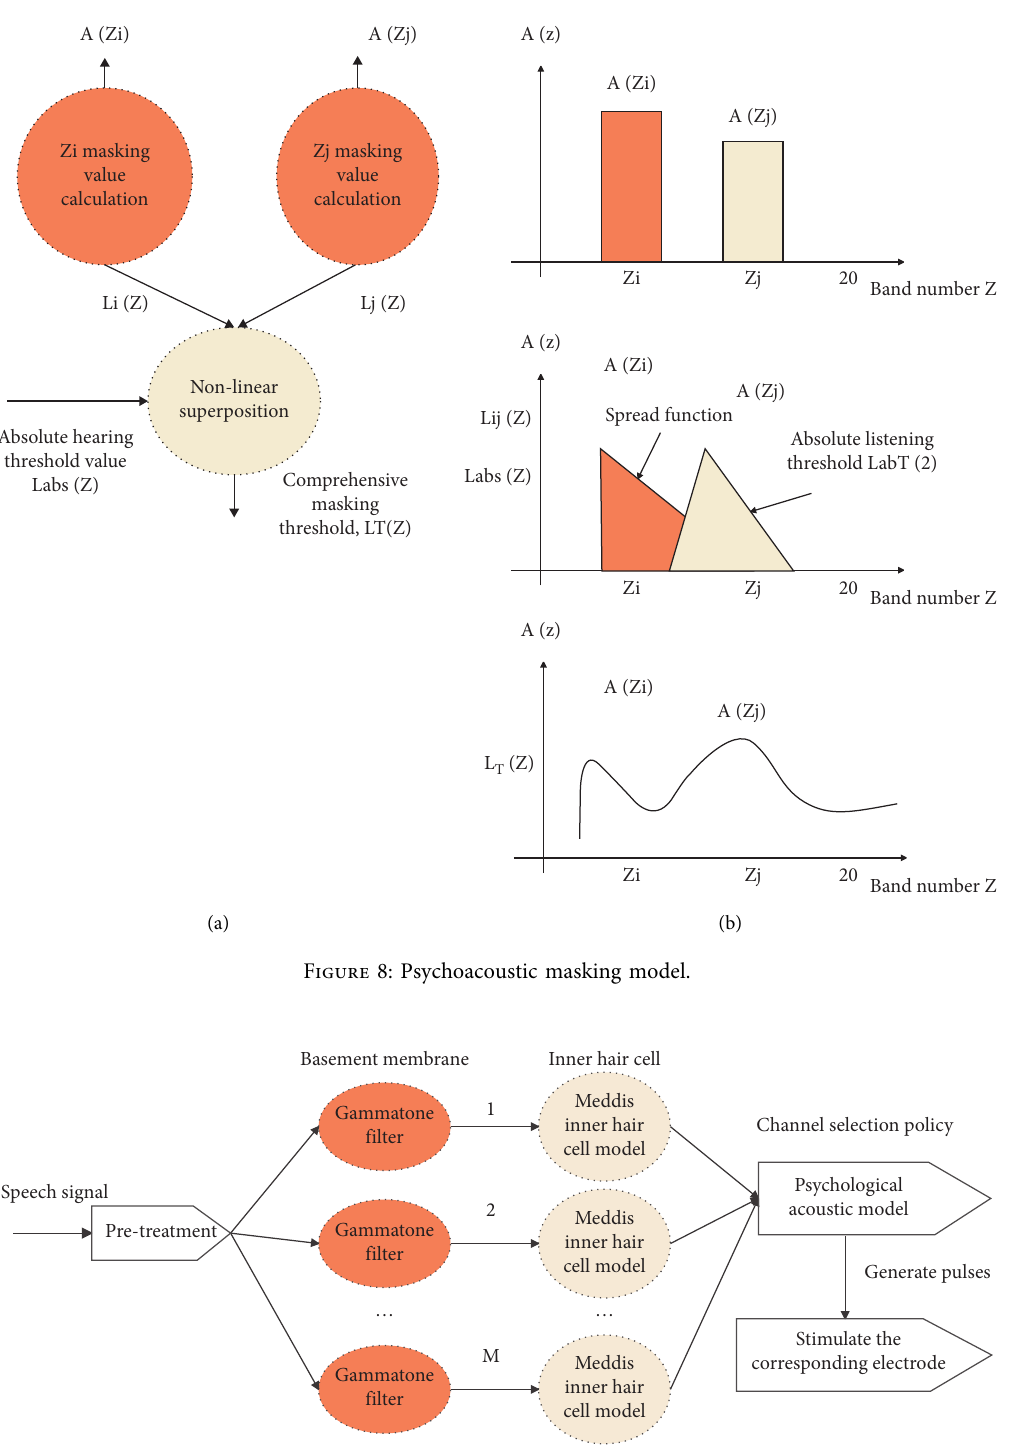
Figure 9: Principle block diagram of a psychoacoustic model coding strategy based on the characteristics of the human